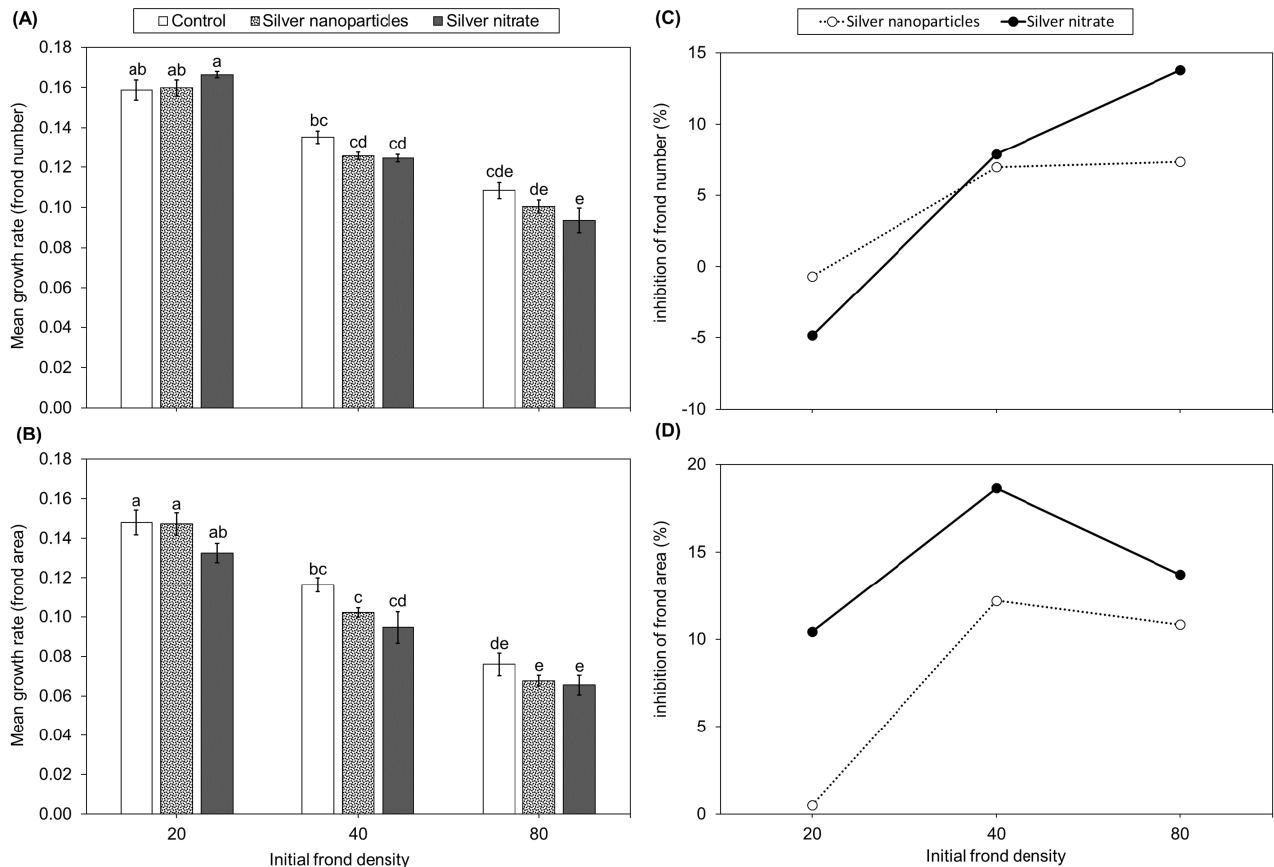
Figure 2. Mean ± standard error growth rate of frond number ( A ) and frond area ( B ) of Lemna minor after 14 days in control, 500 µg/L AgNPs, or 500 µg/L AgNO 3 ( n = 5) and percent inhibition of Lemna minor frond number ( C ) and frond area ( D ) at different frond densities (20, 40, and 80 fronds per 28.5 cm 2 ). Different letters indicate differences among treatments and initial frond density groups (two-way ANOVA, Tukey multiple comparisons tests, p < 0.05).